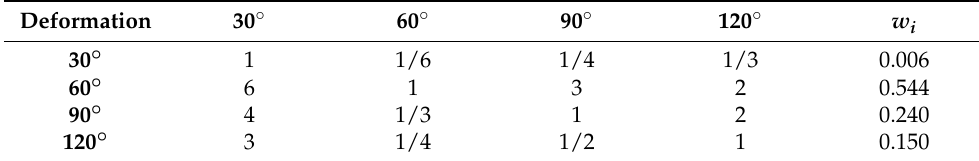
Table 15. Important degree judgment matrix of deformation slower in different wind attack angles.